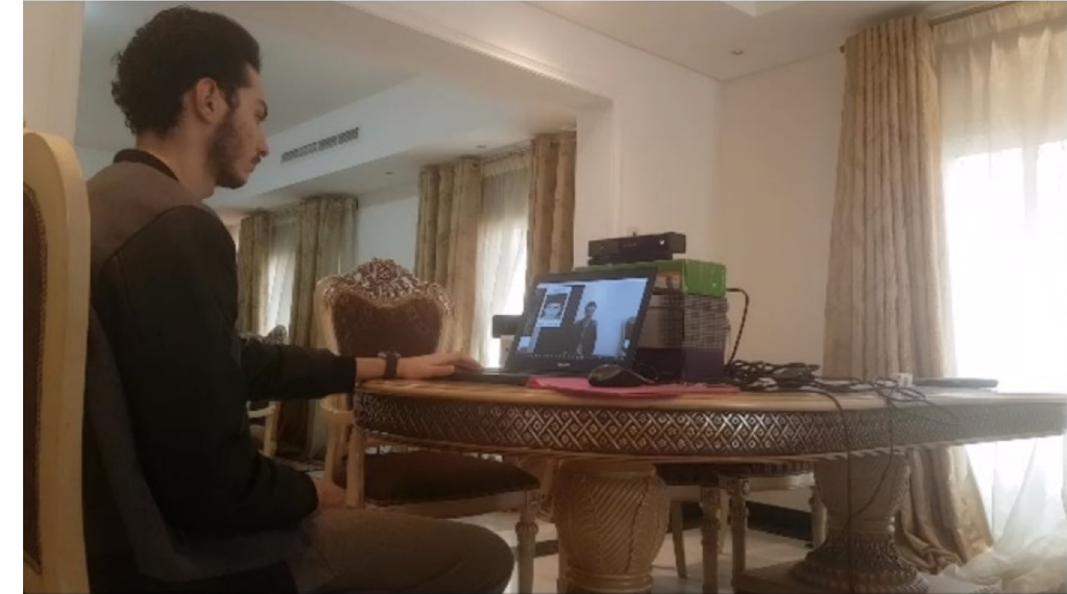
Fig 12. Experiment setup showing one